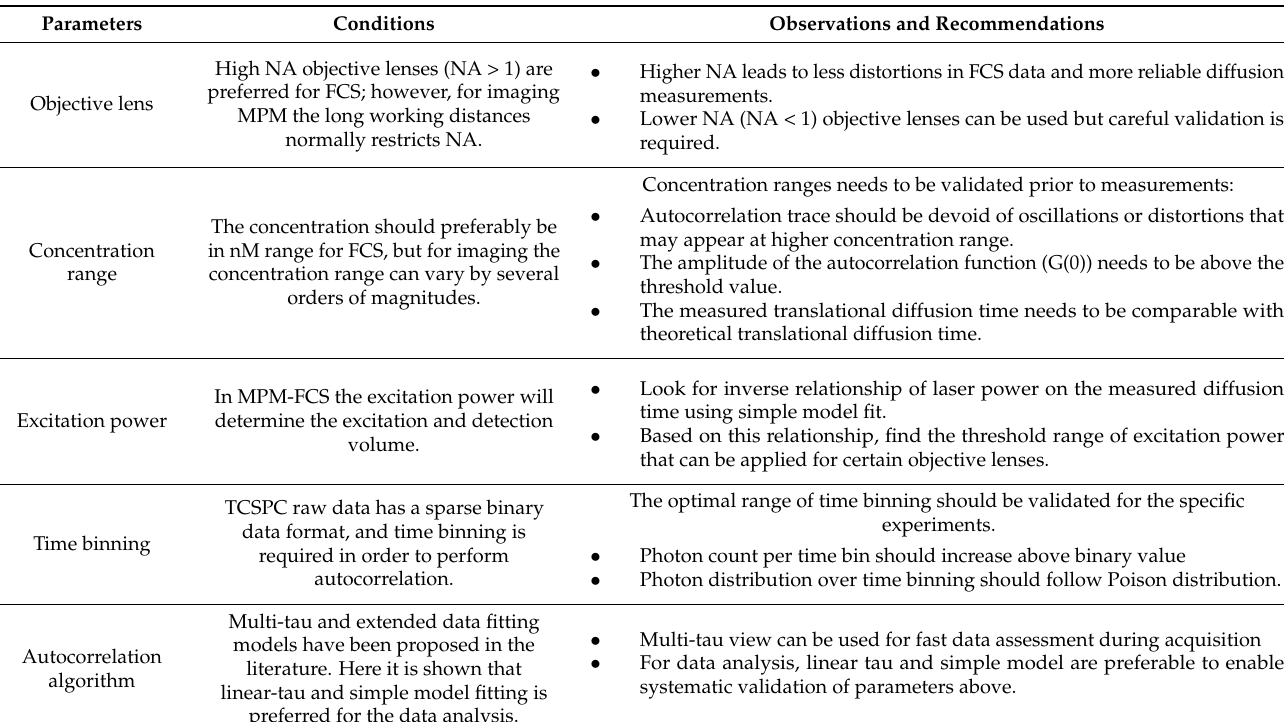
Table 1. Summary of results describing the parameters to be considered for FCS